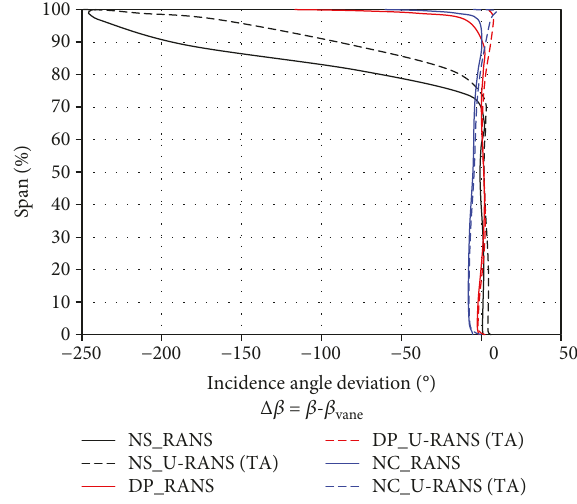
Figure 15: Incidence angle deviation distribution at the vaned di ff user